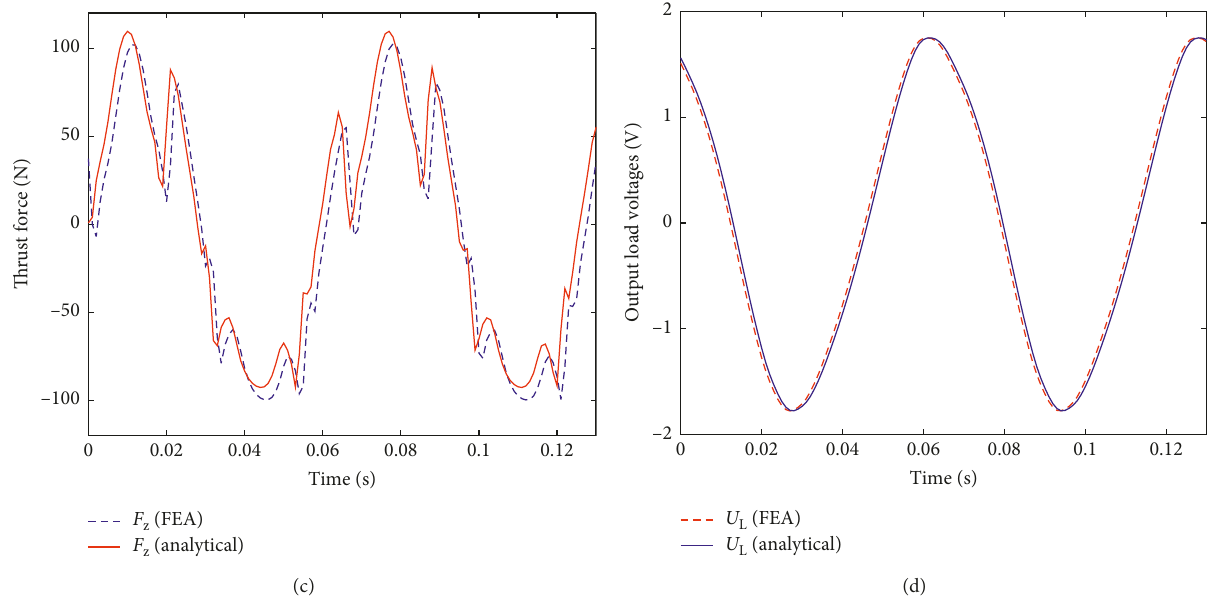
Figure 3: Comparison of FEA and analytical results. (a) Axial output damping force. (b) Load voltage (-1 denotes 1.5Hz and -2 denotes 15Hz).